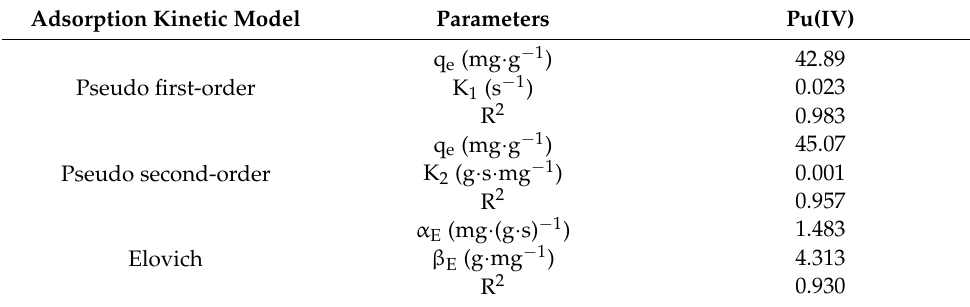
Table 4. Adsorption kinetic parameters for Pu(IV) on